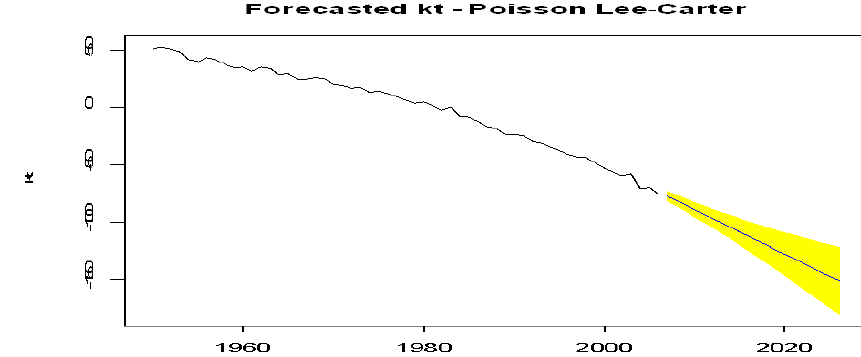
Fig. 2. Poisson Lee-Carter forecasted k t – aggregation by causes of death, Italian total